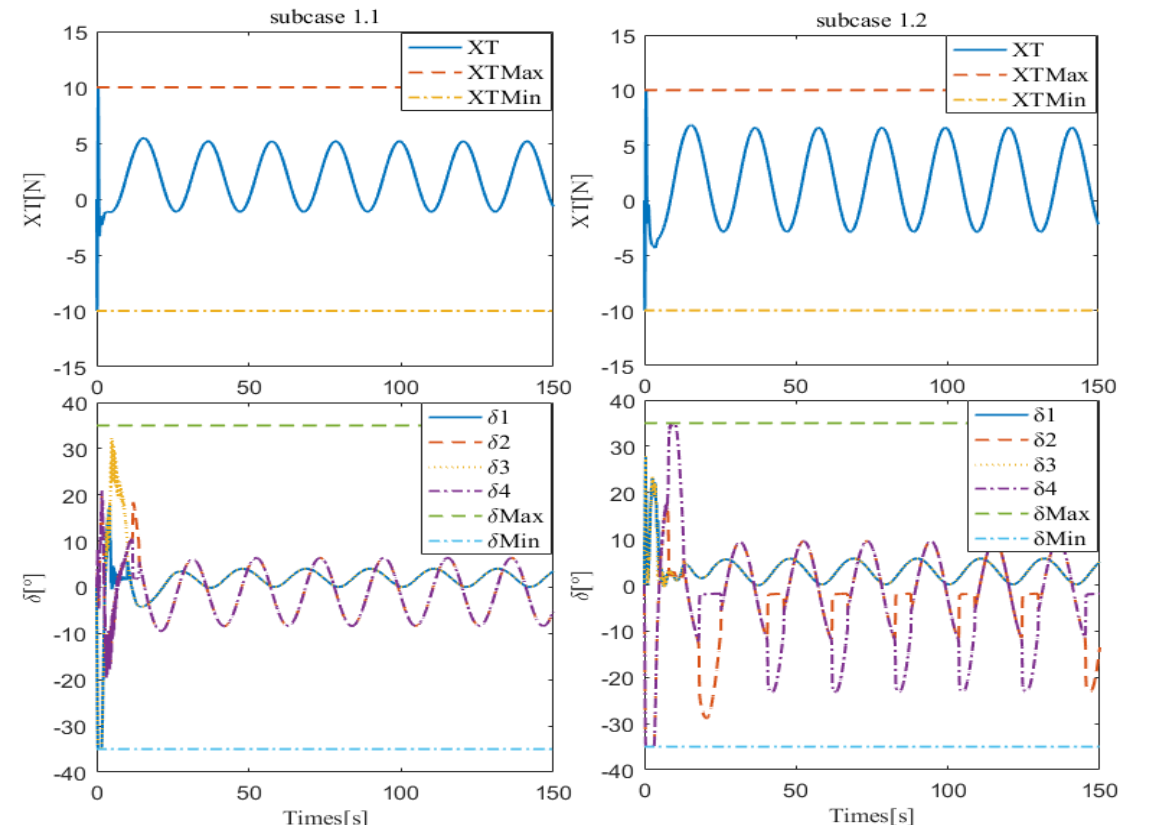
Figure 7. Control inputs of subcases 1.1 and 1.2.